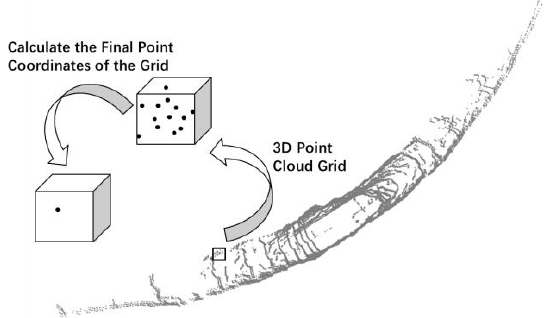
Figure 4. Distance-weight map construction diagram.